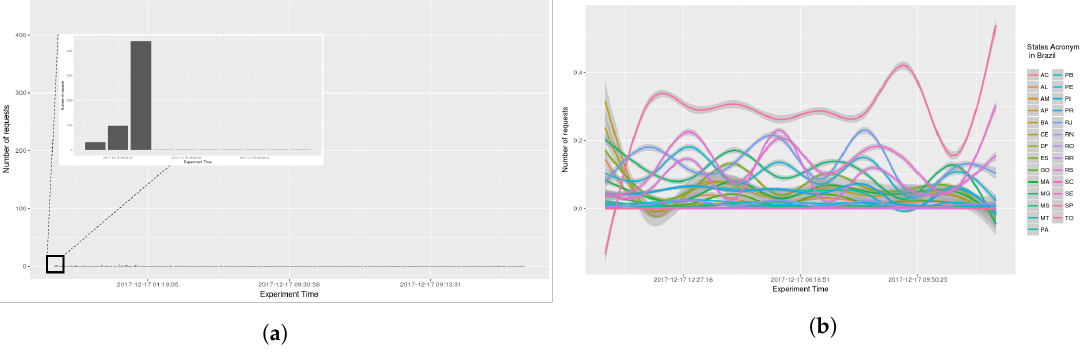
Figure 17. Scenario 04—Time Frequency. ( a ) Stations in the whole country of Brazil; ( b ) Stations grouped by states.